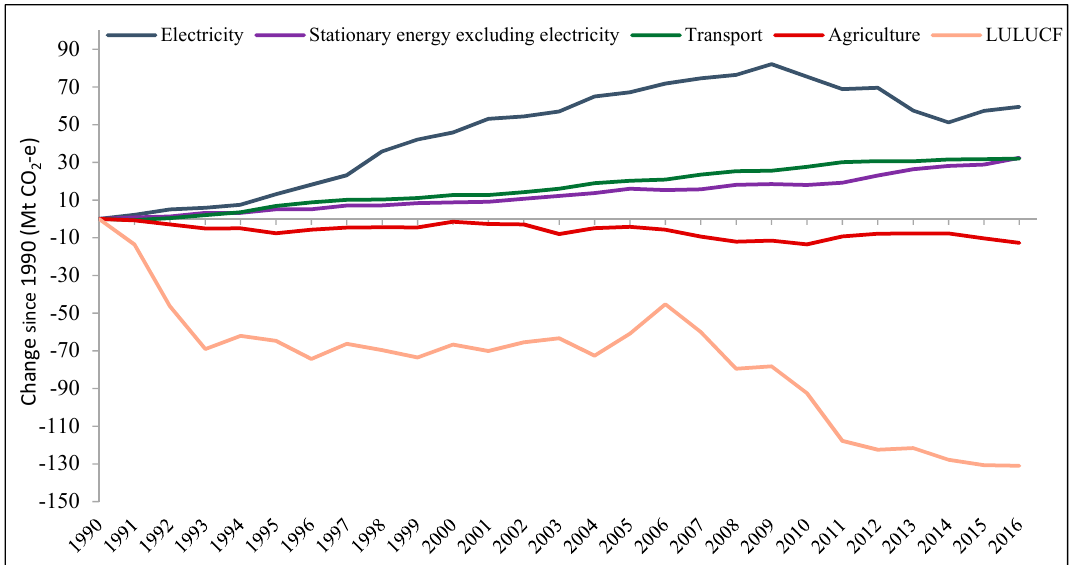
Figure 2. Change in Australia’s greenhouse gas emissions by sector from June 1990 to June 2016 [31].